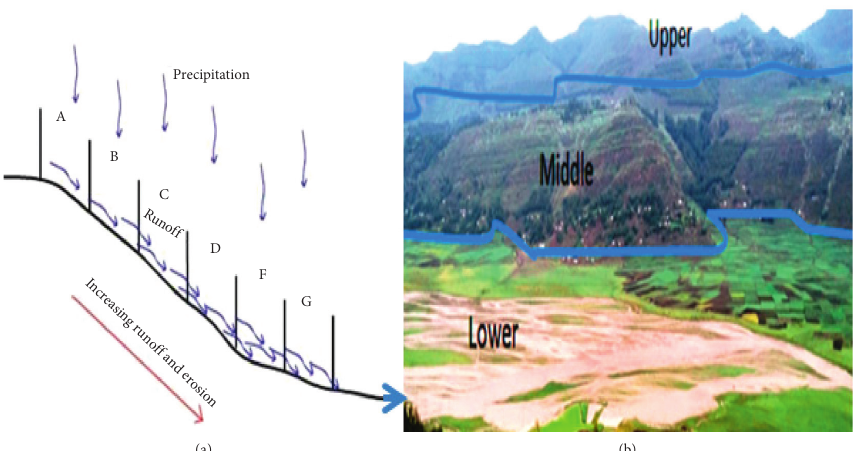
Figure 5: (a) Model sketch for hillslope position and runoff. (b) Flooding at the lower part of the Ayiba watershed during the rainy season (photo courtesy: weldemariam, July